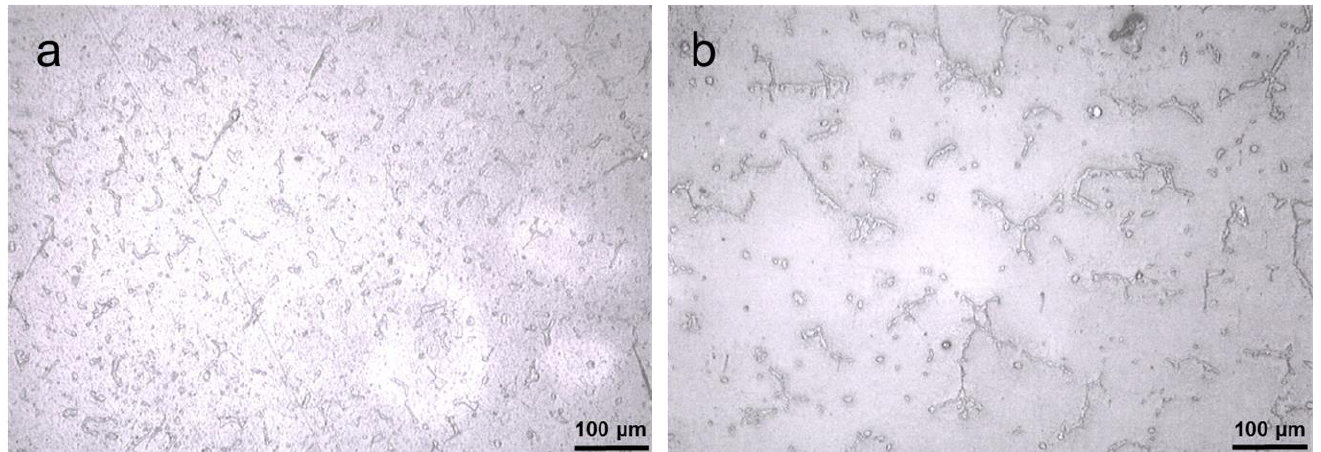
Figure 9. SEM images of BJ impeller surface showing ( a ) large (~400 µ m) and ( b ) small (~50 µ m) shrinkage voids due to metal contraction.